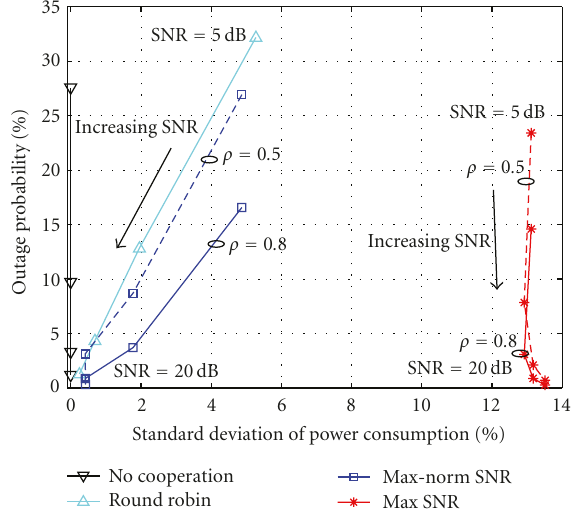
Figure 5: Outage probability versus standard deviation of the power consumption of the di ff erent relay selection mechanisms for di ff erent values of ρ and System SNR (System SNR = { 5,10,15,20 } dB, K = 5 relays, R = 1bit/s/Hz, d = 100 m. Solid line: ρ = 0.8, dashed line: ρ =